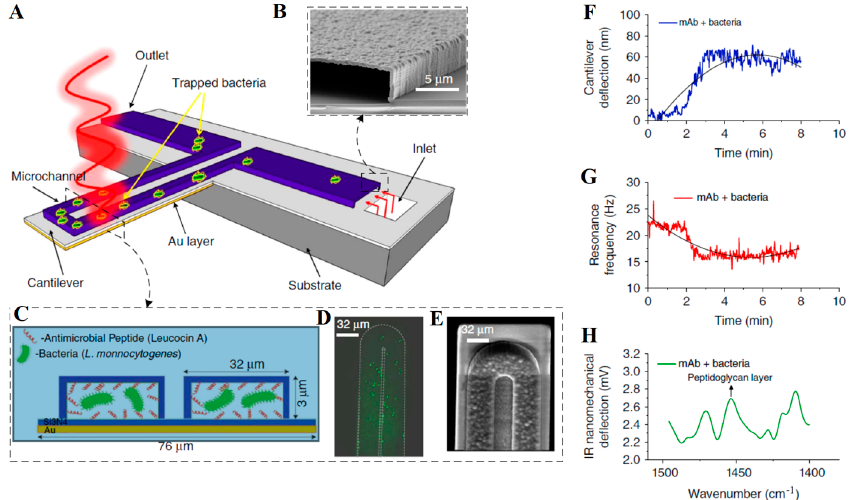
Figure 10. A schematic representation of the BMC and its multimode operation [143]. ( A ) BMC filled with bacteria supported on a silicon substrate; ( B ) SEM image of the cross section of an inlet; ( C ) cross section of microchannel on BMC modified with mAb or AMP; ( D ) fluorescent image from the top side of the BMC, filled with bacteria; ( E ) SEM image of the tip of the BMC; ( F ) deflection of BMC caused by heat when bacteria absorb infrared light; ( G ) resonance frequency changes with the quality of bacteria; ( H ) selective absorption of infrared light by bacteria.